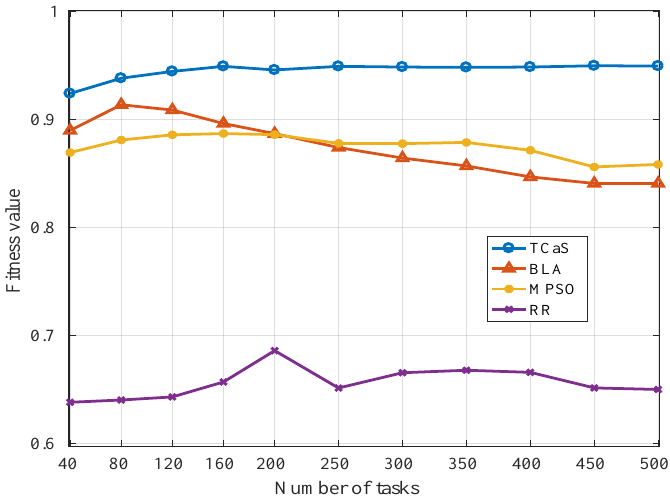
Figure 5. Time–cost trade-off comparison of the four algorithms.